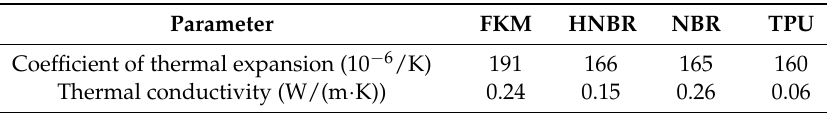
Table 6. Thermal parameters of used